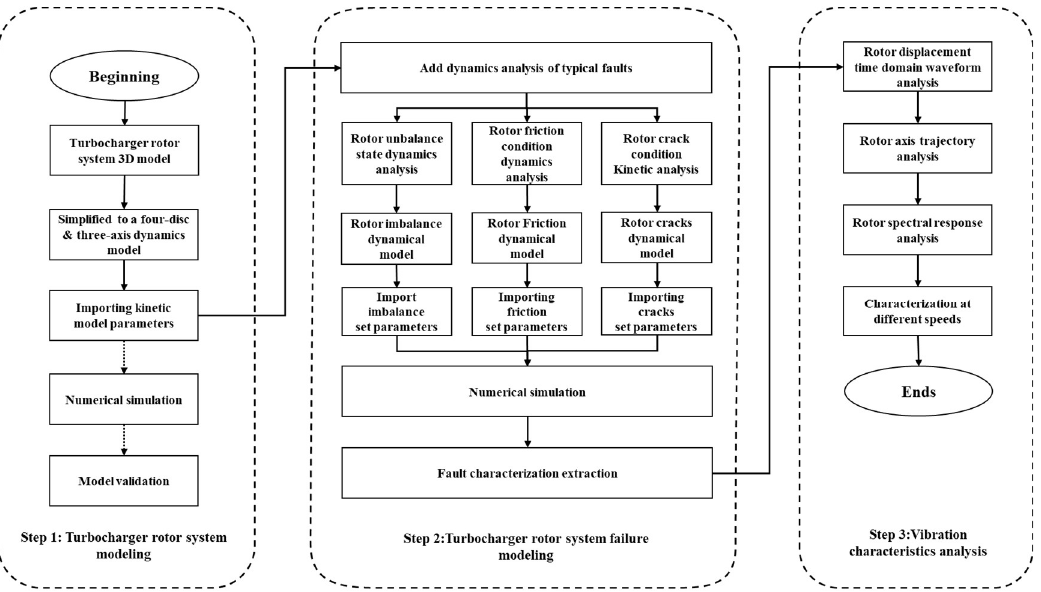
Figure 4. Flow chart of typical fault modeling and vibration characteristics study of the turbocharger rotor system.